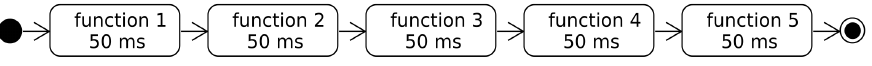
Figure 1. A function chain with five 50 ms functions. If the cold start latency is assumed as 100 ms, the response time is 750 ms for the first